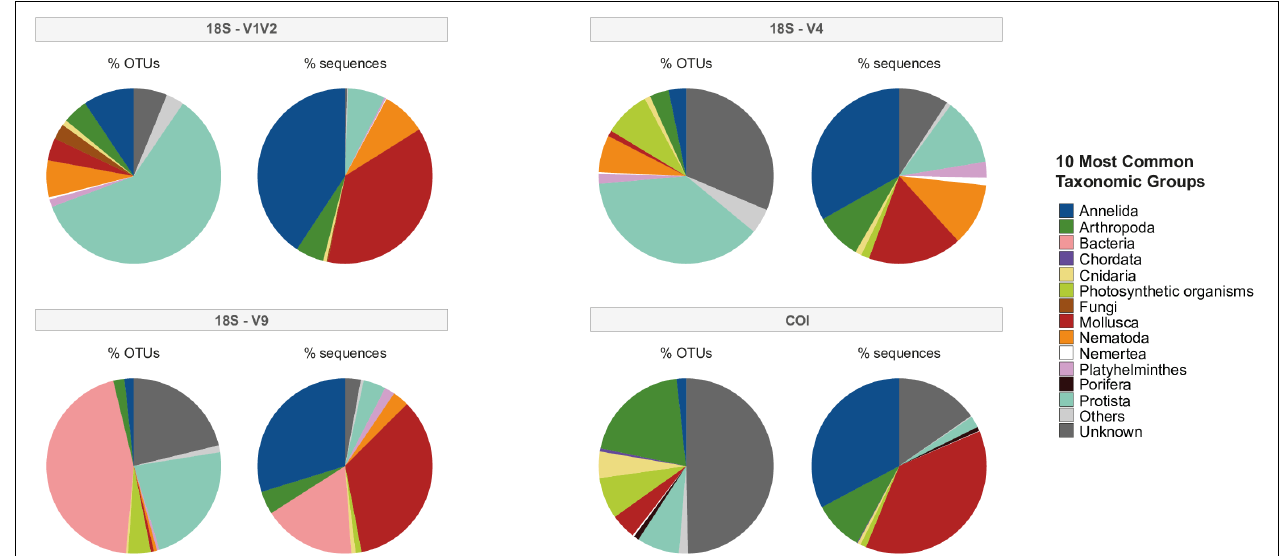
FIGURE 2 | The top 10 most common taxonomic groups, including non-metazoans, from the global eDNA sequencing effort for the four eDNA datasets. Percentage of OTUs refers to the proportion of OTUs (“species”) originating from each phylum and percentage of sequences (“abundance”) refers to the proportion of reads originating from each